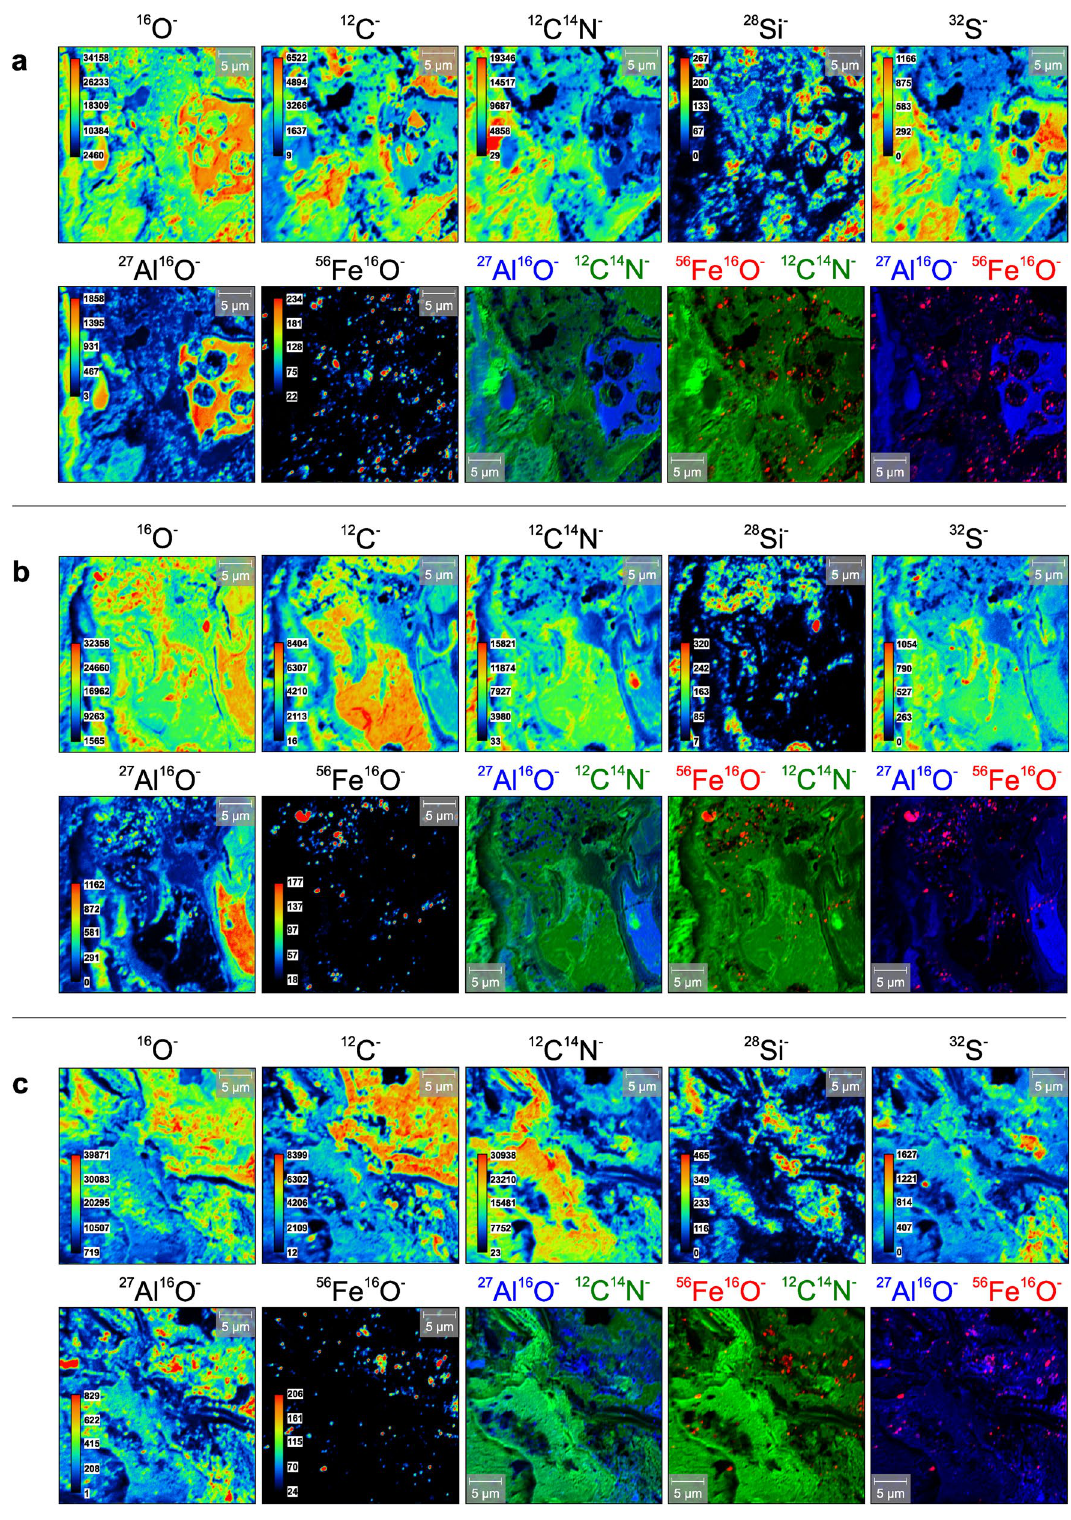
Figure 5. NanoSIMS secondary ion mappings of nano- to micrometer-scale intra-aggregate components. (a–c ) Spatial distribution of 16 O − , 12 C − , 12 C 14 N − , 28 Si − , 32 S − , 27 Al 16 O − , and 56 Fe 16 O − secondary ions measured on 30 × 30 μm surfaces within the organic-rich matrix of the soil aggregates. In addition, composite images calculated from 12 C 14 N − , 27 Al 16 O − and 56 Fe 16 O − data are